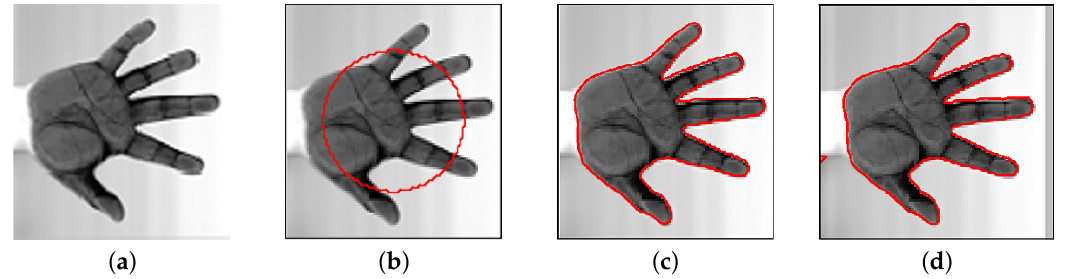
Figure 12. Hand image segmentation. ( a ) Original image from [23] that Copyright 2016 Society of Photo Optical Instrumentation Engineers. ( b ) Initial condition with a circle. Segmented contour line (red color) and original image using ( c ) our proposed method and ( d ) the previous method